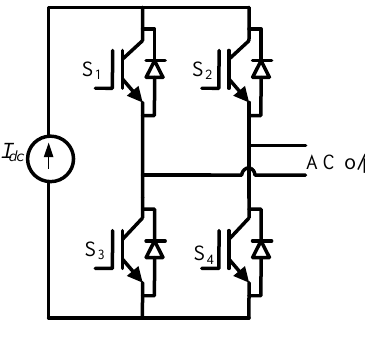
Figure 8. Current source inverter.